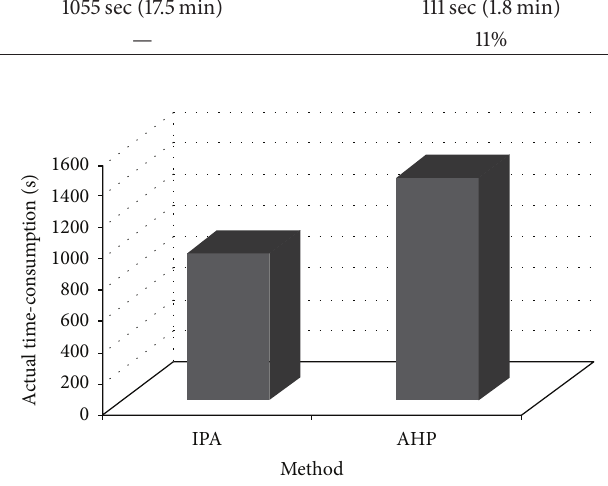
Figure 7: The actual time-consumption for each prioritization task, derived from start/end times recording automatically by the prioritization tools.